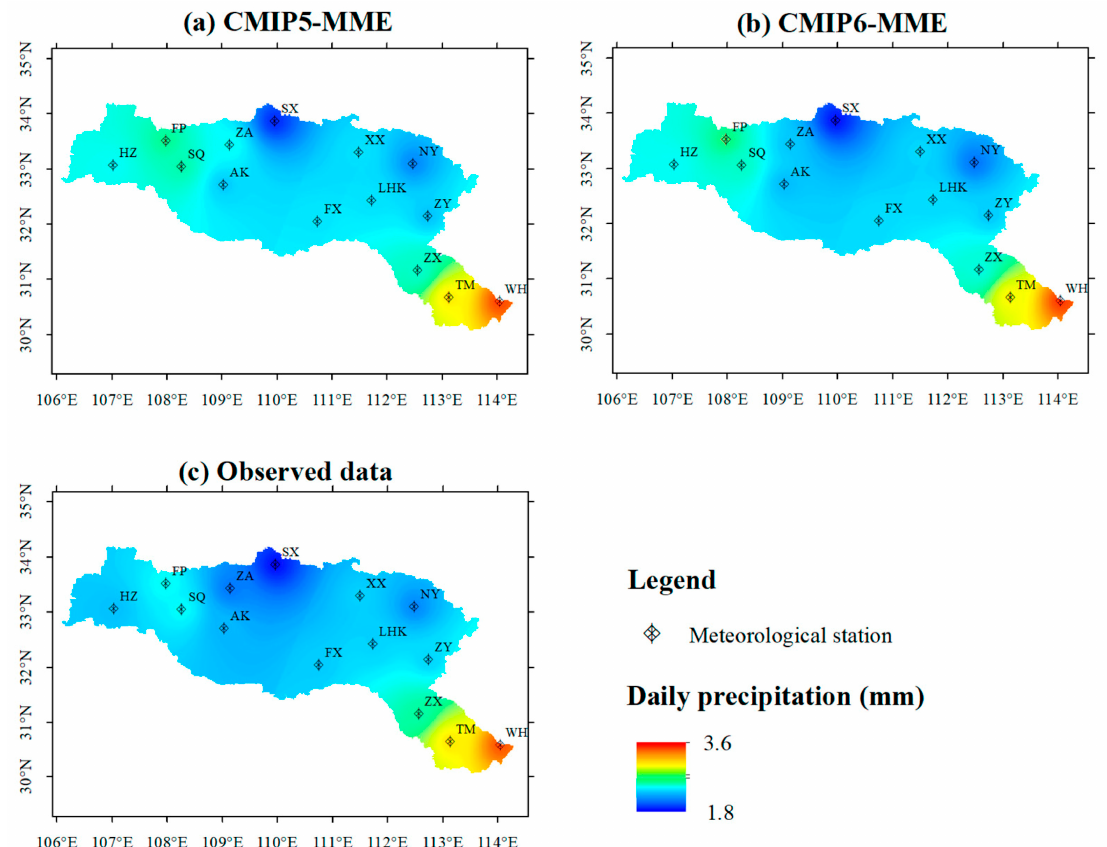
Figure 6. Mean daily precipitation of ( a ) CMIP5-MME downscaled data, ( b ) CMIP6-MME downscaled data, and ( c ) observed data over HRB from 1970 to 2005.